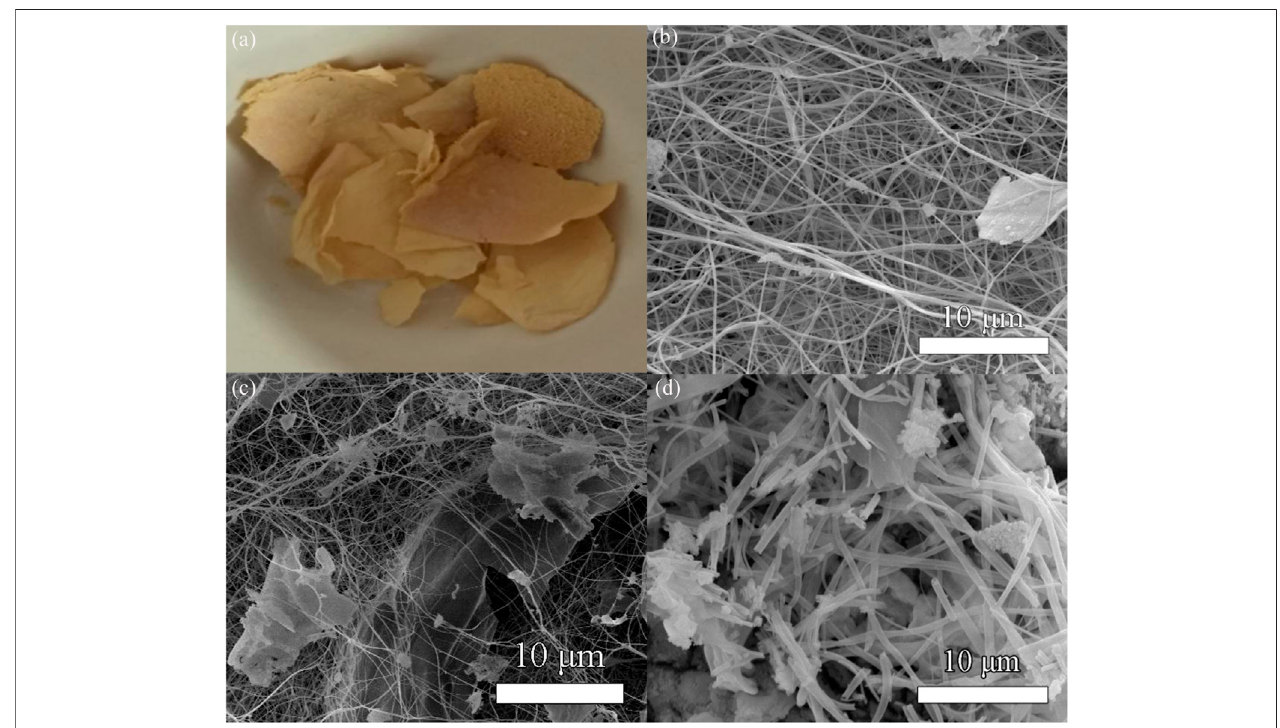
FIGURE4|(A) RealphotographsofAg/CeO 2 fi ber membranes. SEMimagesoftheceriumoxide fi ber dopedwithnano-silverwiththeAg/CeO 2 molarratios of (B) 1:50, (C) 3:50, and (D) 5: